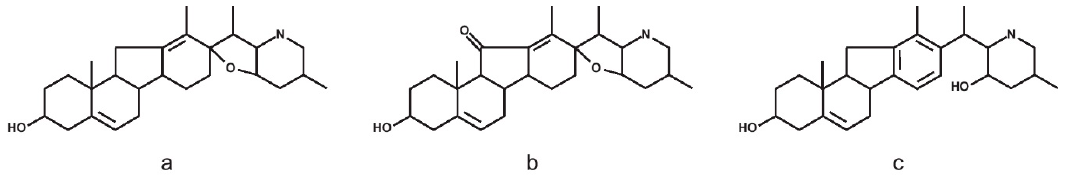
Figure 1. Chemical structures of cyclopamine ( a ), jervine ( b ), and veratramine ( c ).